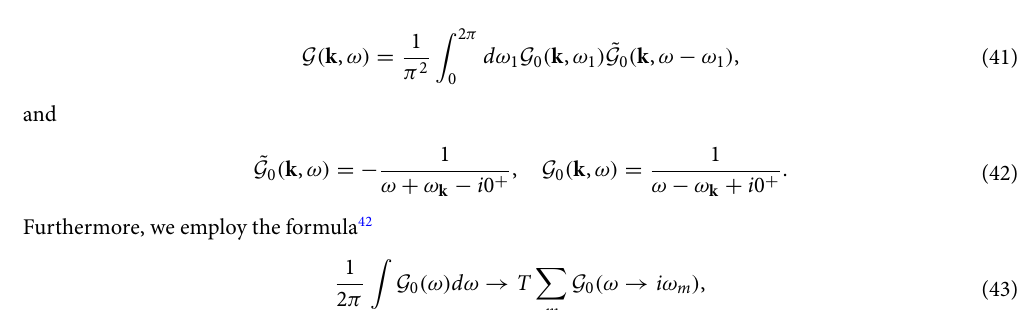
0.2 . The J 2 value is near to the phase transition =